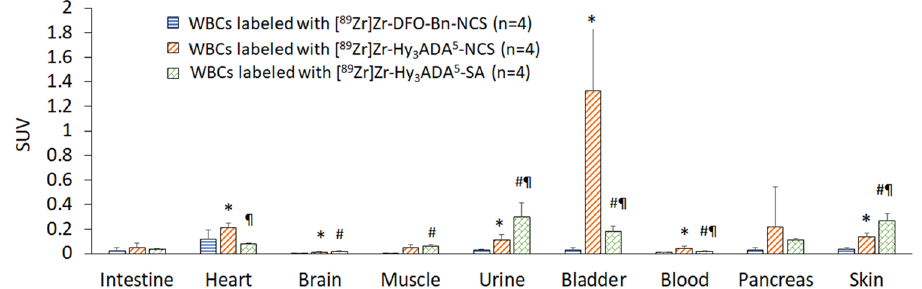
Figure 7. Uptake (SUV) and biodistribution of WBCs labeled with [ 89 Zr]Zr-DFO-NCS, [ 89 Zr]Zr-Hy 3 ADA 5 - NCS and [ 89 Zr]Zr-Hy 3 ADA 5 -SA synthons in athymic nude mice at day 7 post-injection. *p < 0.05 WBCs labeled with [ 89 Zr]Zr-DFO-Bn-NCS Vs [ 89 Zr]Zr-Hy 3 ADA 5 -NCS; # p < 0.05 WBCs labeled with [ 89 Zr]Zr-DFO-Bn-NCS